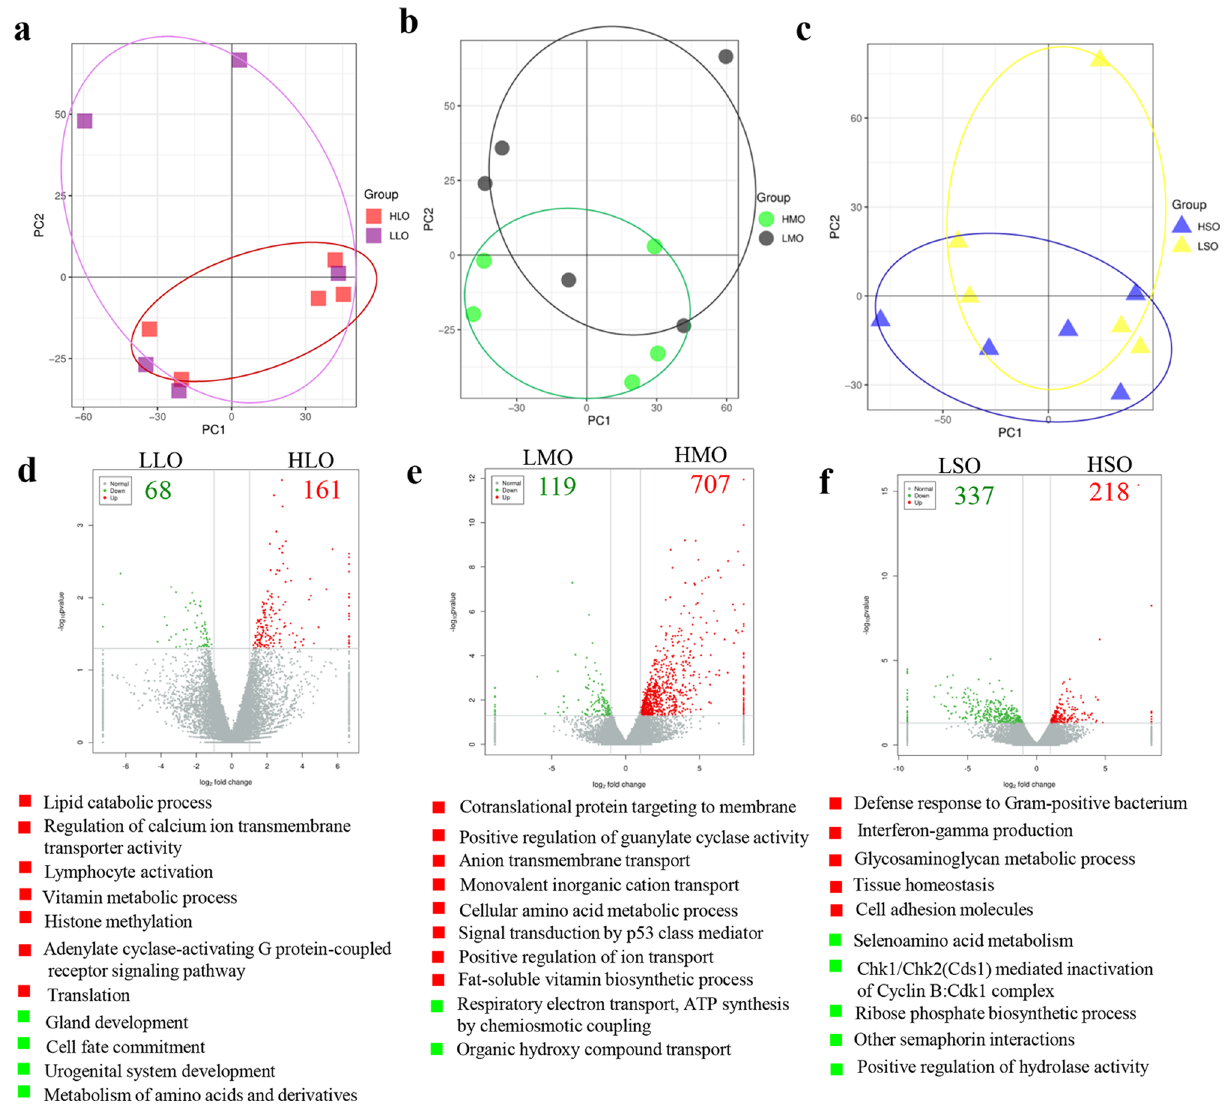
Figure 3. Dynamic gene expression in oocytes of different fertility groups throughout folliculogenesis. ( a ) PCA of oocytes in large follicles of high fertility and low fertility samples (HLO vs. LLO). ( b ) PCA of oocytes in medium follicles of high fertility and low fertility (HMO vs. LMO). ( c ) PCA of oocytes in small follicles of high fertility and low fertility (HSO vs. LSO). ( d ) Differentially expressed genes (DEGs) in oocytes of large follicles from high fertility group and low fertility group, and the top enriched function pathways. Red indicates the gene expressed higher in HLO; green indicate the gene expressed higher in LLO. ( e ) Differentially expressed genes (DEGs) in oocytes of medium follicles from high fertility group and low fertility group, and the top enriched function pathways. Red indicates the gene expressed higher in HMO; green indicate the gene expressed higher in LMO. ( f ) Differentially expressed genes (DEGs) in oocytes of small follicles from high fertility group and low fertility group, and the top enriched function pathways. Red indicates the gene expressed higher in HSO; green indicate the gene expressed higher in